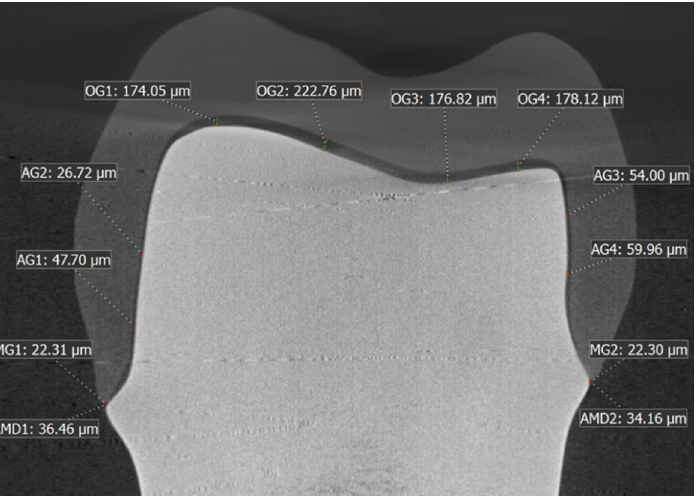
Figure 5. Representative image of the crown-master metal die bucco-lingual section of the nano-CT 3D scan model showing the internal and marginal gap width measurements. 3D scan model showing the internal and marginal gap width